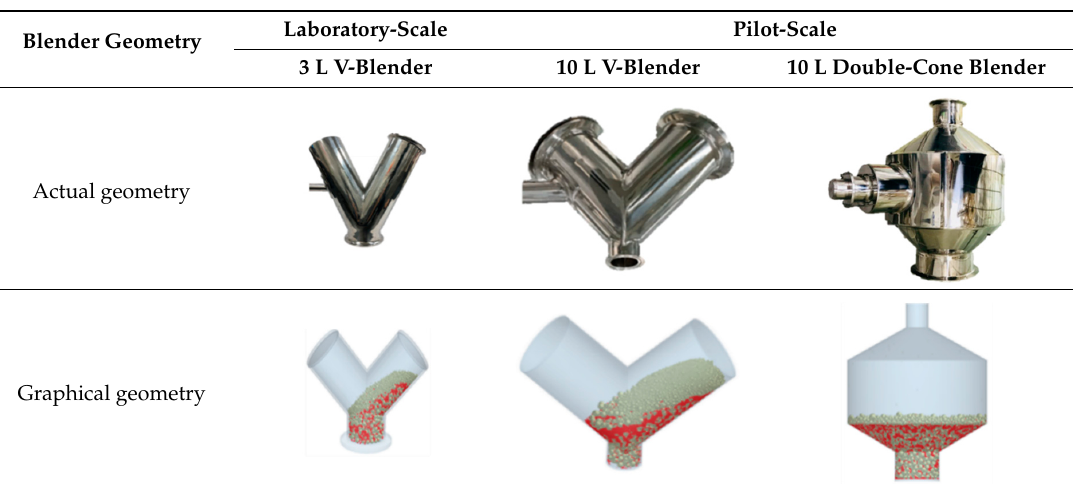
Table 1. Blender geometry in actual experiments and